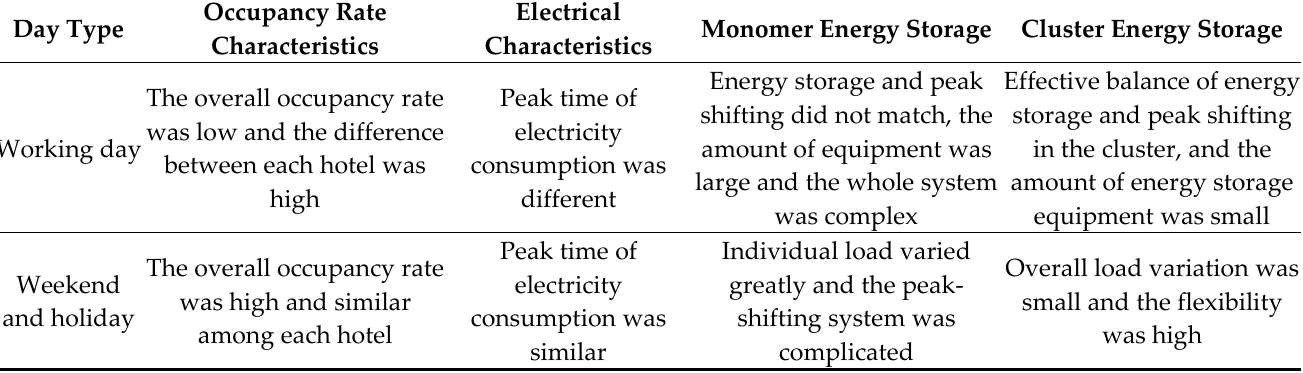
Table 3. Comparison of energy storage peak-shifting